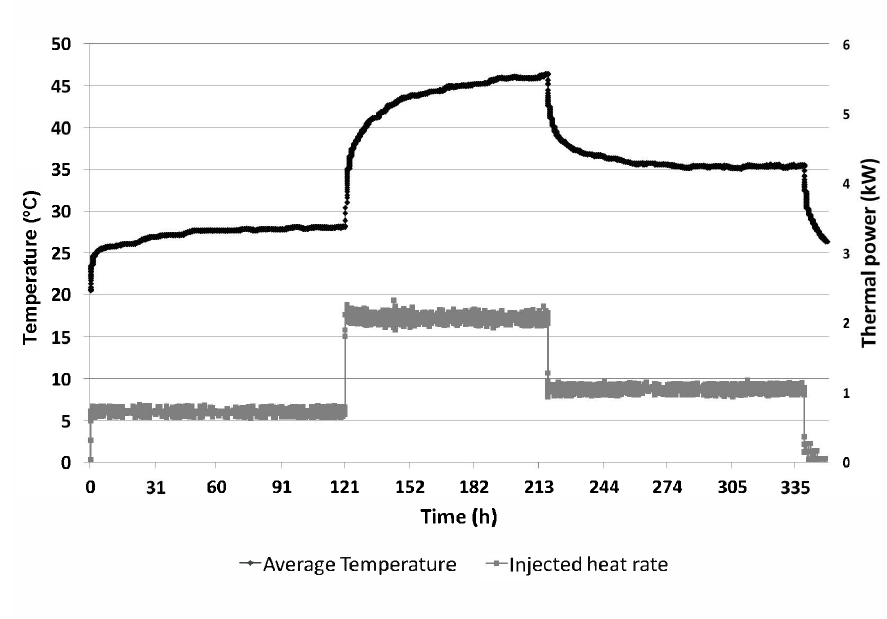
Figure 5. Data recording from the thermal installation during the